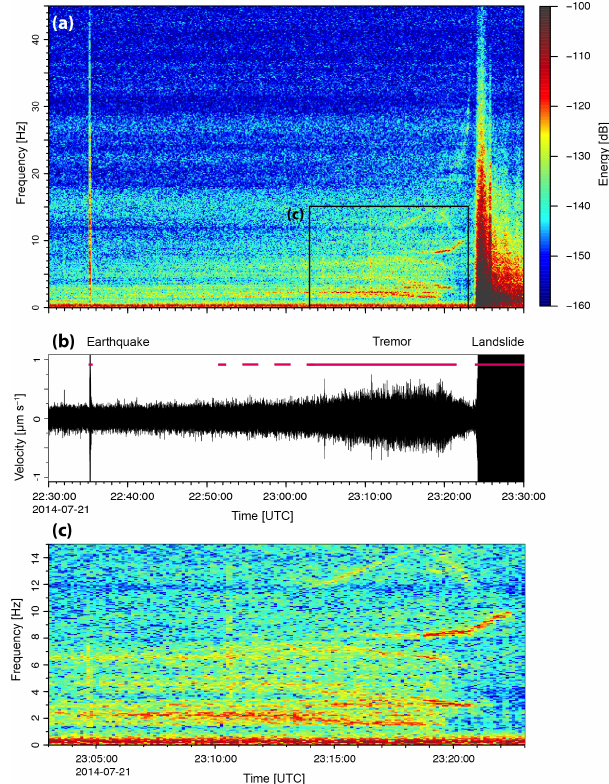
Figure 6. (a) Spectrogram (unfiltered) and (b) waveform (filtered between 1 and 45Hz) of the tremor signal preceding the 21 July 2014 Askja landslide. (c) Close-up of the tremor signal with up- and down-gliding spectral lines. MOFO station, east